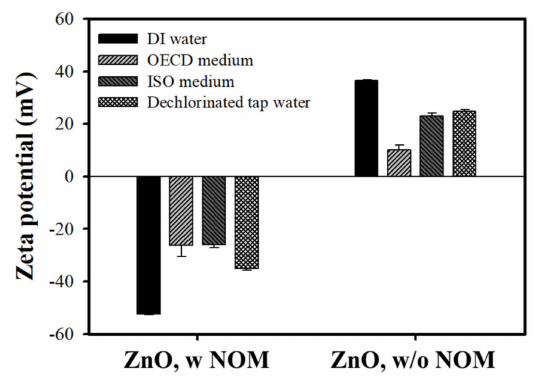
Figure 3. Zeta potential of ZnO NPs with / without NOM. Values on the graph represent mean ± standard deviation.